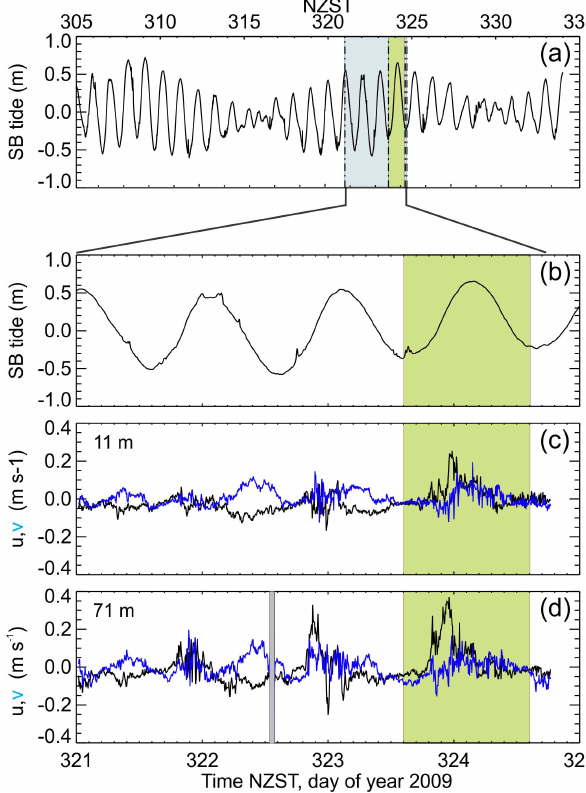
Fig. 4. The tidal elevation (a) at Scott Base is expanded (b) to high- light a four day segment within which our ADCP (grey box in a) and turbulence profiling (green box in all panels) were recorded. Eastward and northward currents, roughly approximating along and across glacier directions) are shown for depths of (c) 11 and (d) 71m. The grey bar was a period of no data return from the 71m depth